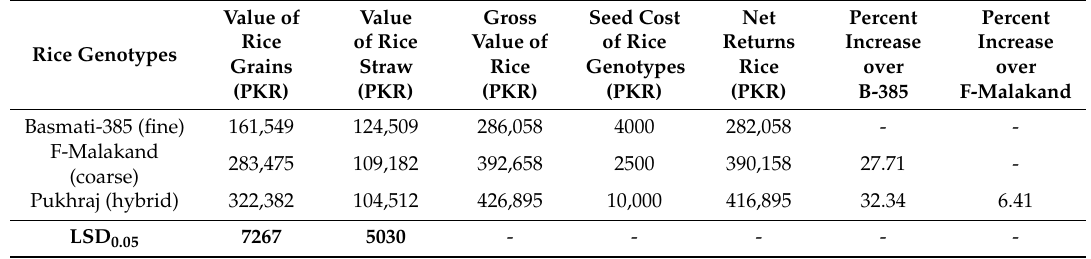
Table 6. Impact of di ff erent rice genotypes on the economic analysis under rice–wheat cropping system.